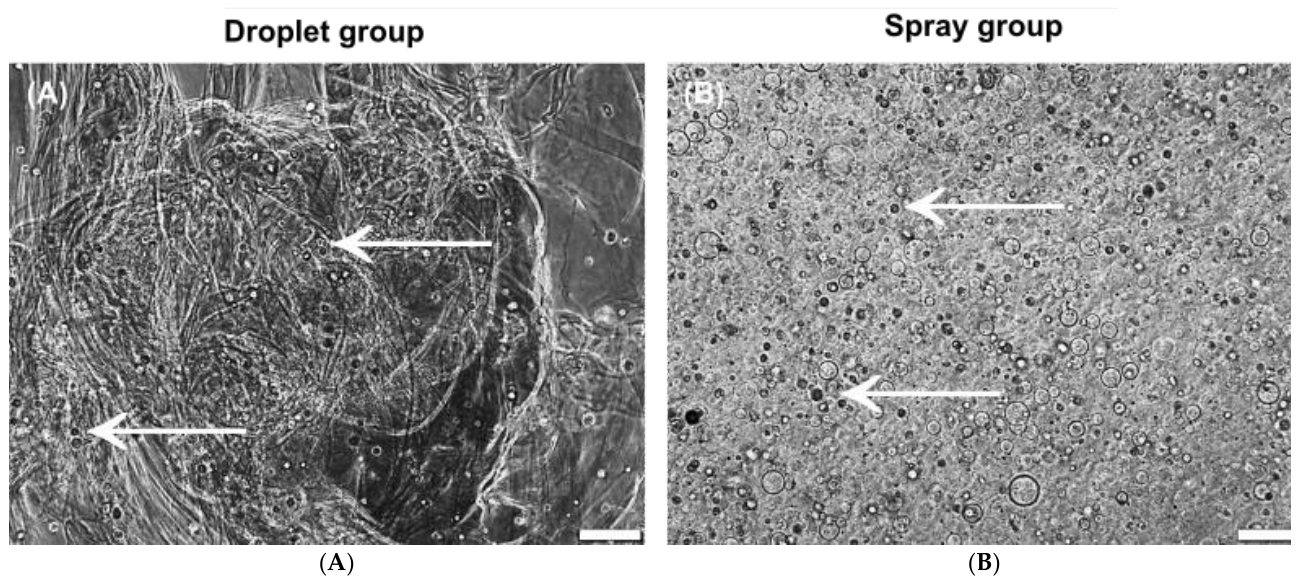
Figure 2. Gel structure and distribution of keratinocytes after droplet and spray application. ( A , B ) Representative images of dripped ( A ) and sprayed ( B ) keratinocytes at time point 1d, phase contrast. Scale bar 200 µm. ← for better cell demonstration and identification of cell morphology.